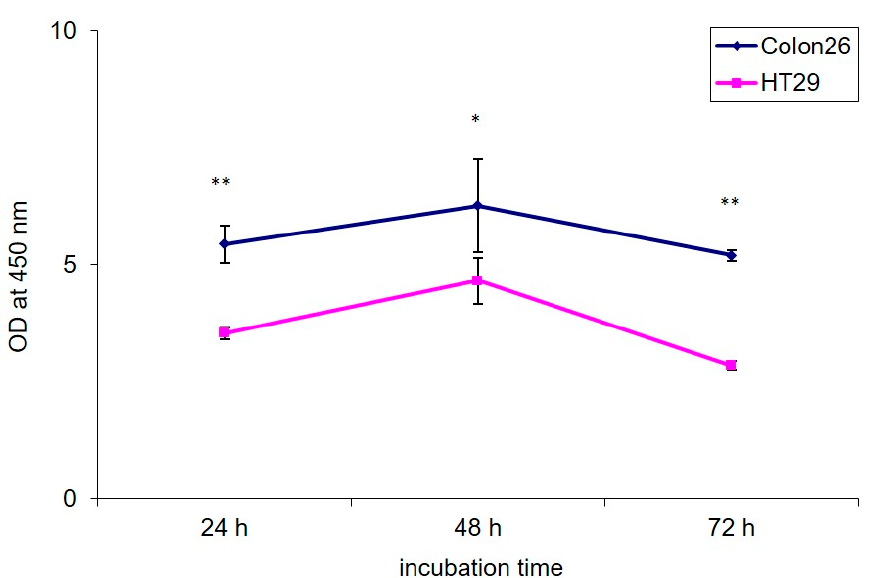
Figure 2. Proliferation activity of Colon26 and HT29 cells. Cells were seeded in 96-well plates at a density of 2.5 × 10 4 cells/well and were incubated for 72 h. During cultivation the WST-1 assay was performed at three time points: 24 h, 48 h and 72 h, to assess cell growth. The optical density was measured at 450 nm using an ELISA reader. The error bars represent the standard errors of the mean OD at 450 nm assessed with WST-1 method (SEM). Statistically significant differences between the two cell lines in the OD were analyzed by Dunnett’s test and are denoted as * p < 0.01 and ** p <